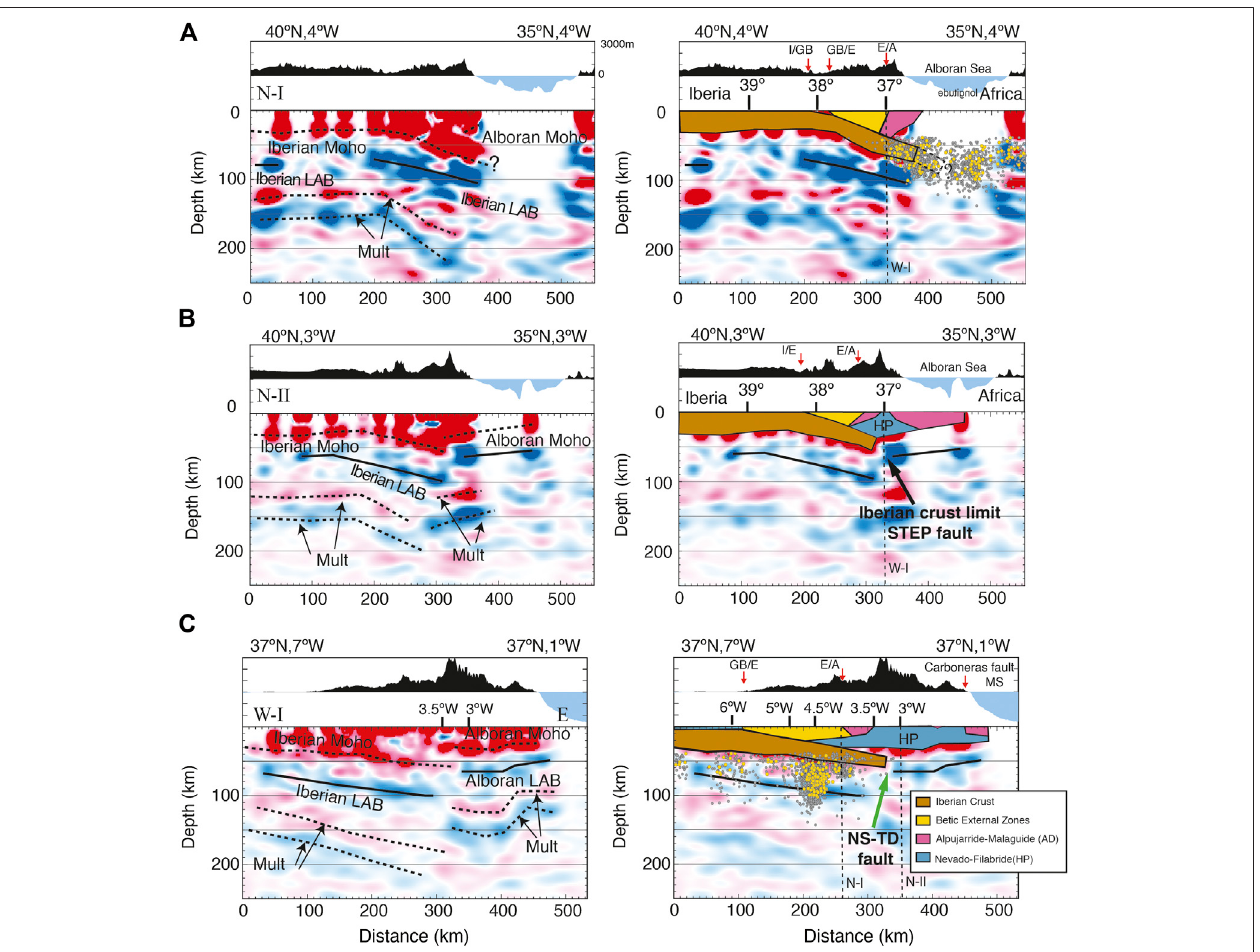
FIGURE 2 | Common conversion point images build with P-wave Receiver Functions (left panels) and their interpretation sketches (right panels). (A,B) are NS- cross-sections (N-I and N-2 see Figure 1 ) is WE-cross-section (W-I). In the stacked images, red colors (positive amplitudes) in a seismic discontinuity mean velocity increase with depth. The dashed black lines mark the inferred conversion depth of the Ps converted phase at the crustal-mantle boundary (the Moho discontinuity) and its fi rst multiple reverberated phases generated at this discontinuity. Multiples (abbreviated Mult), although not migrated to their correct geometrical position, are useful to con fi rm the trend of the Moho discontinuity. Continuous black lines draw the Lithosphere-Asthenosphere boundary (LAB). At the top of each panel, we display the topography along the pro fi le. Red arrows mark the contact, at the surface, between the different units (I, Iberian Massif; E, External zones; A, Alboran domain; GB, Guadalquivir basin). Common conversion point images modi fi ed from Mancilla and Diaz (2015). We plot the intermediate seismicity (depths > 40 km; gray dots) for the ISCcatalogtogetherwiththehigherprecisionrelocationsofsomeofthemfromSantos-Buenoetal.(2019)(yellowdots).Verticalthindashedlinesarethecrossingpoints with the other pro fi les in the fi